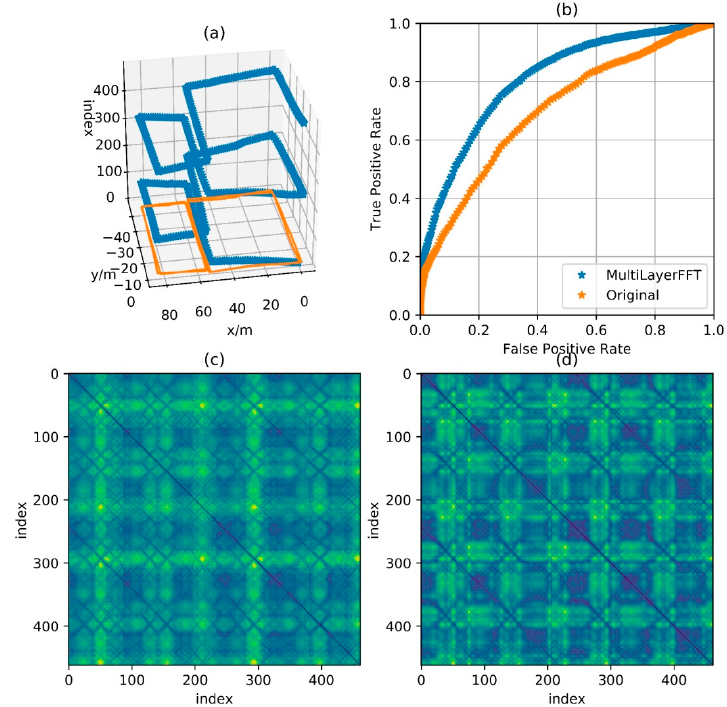
Figure 12. Comparison of performance between BDD and MFD in Path B. ( a ) Reference trajectory. ( b ) ROC of BDD and MFD. ( c ) Distance matrix of BDD. ( d ) Distance matrix of MFD.